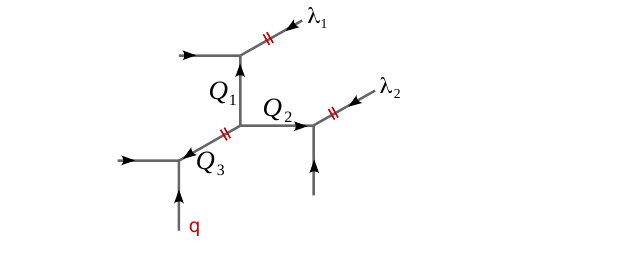
Figure 7 . The T 2 web with non-empty Young diagrams associated to the external (1 ; 1)